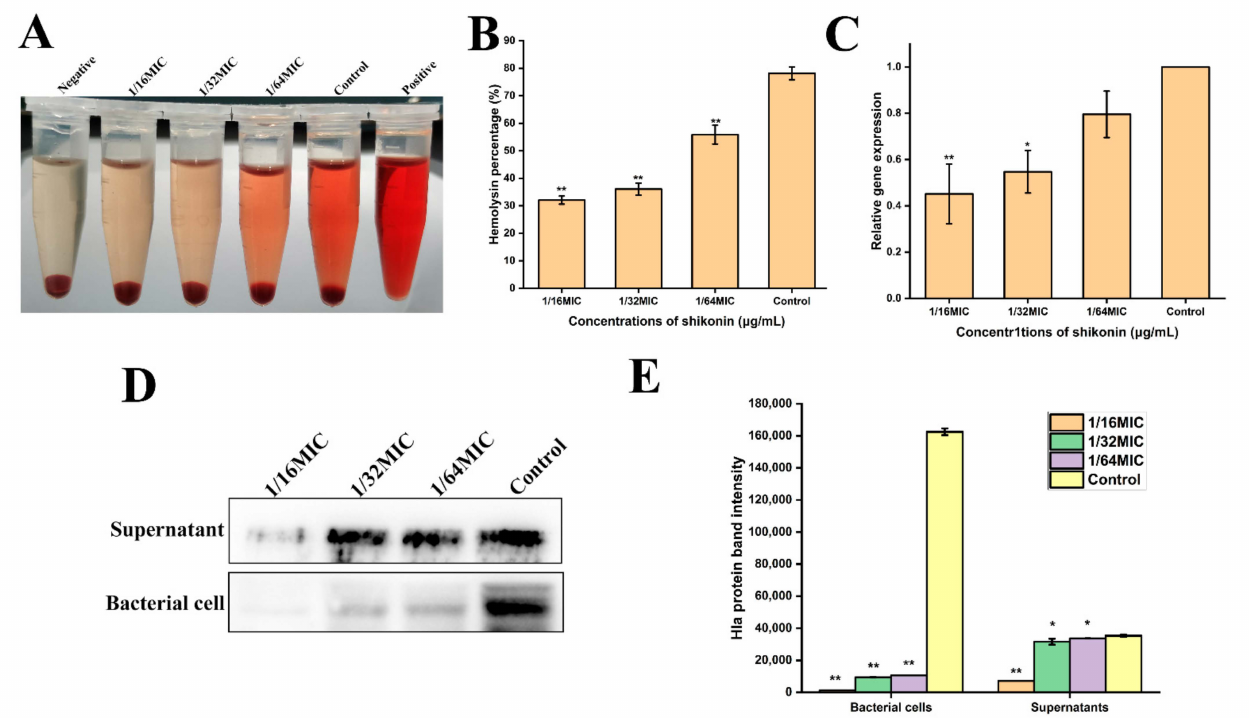
Figure 8. Shikonin at non-inhibitory concentration inhibited the hemolytic ability of S. aureus . ( A , B ) Changes in hemolytic ability of S. aureus strain ATCC29213 following treatment of shikonin; ( C ) The gene transcription of hla ; ( D , E ) The protein expression of Hla was detected by Western blot and densitometry. ** p < 0.01, * p < 0.05.